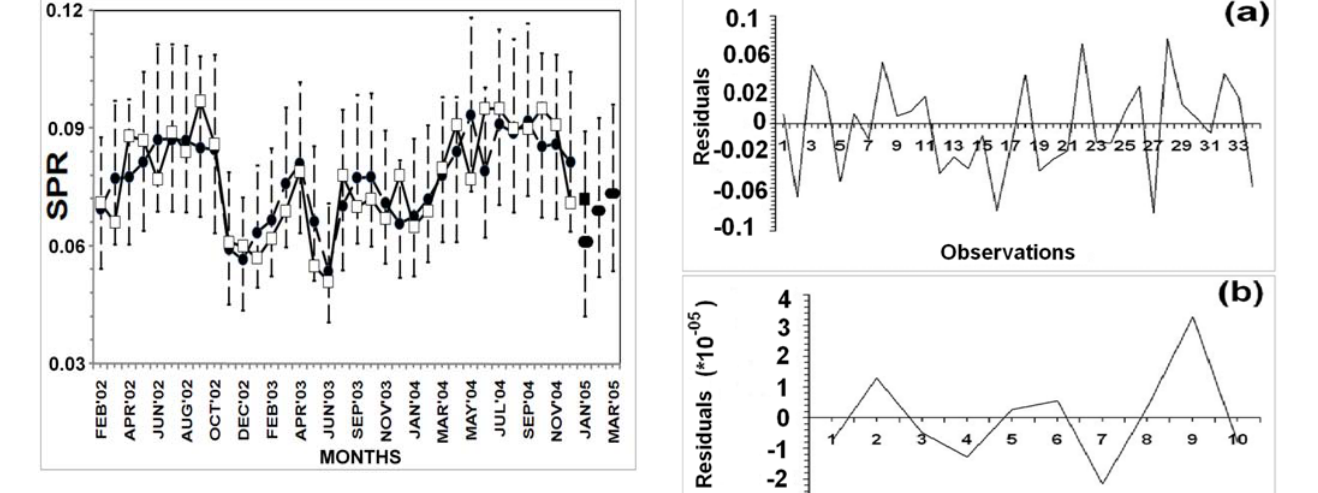
F-values (Tabulated)– at 5% significance level (two-tailed